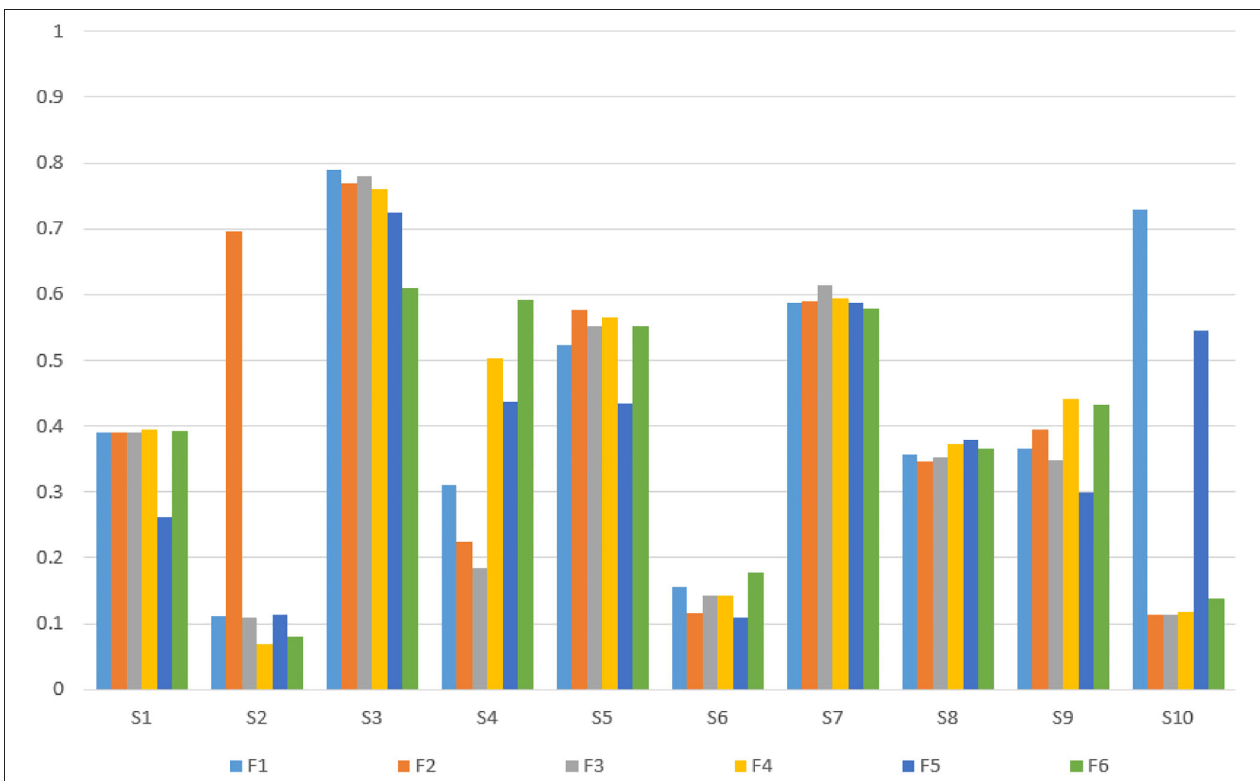
FIGURE 9 | PLV of fatigue sensitive channel P6 to frontal channels of 10 young